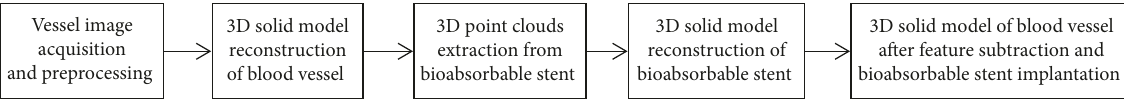
Figure 1: The flowchart of our proposed framework on patient-specific coronary artery 3D